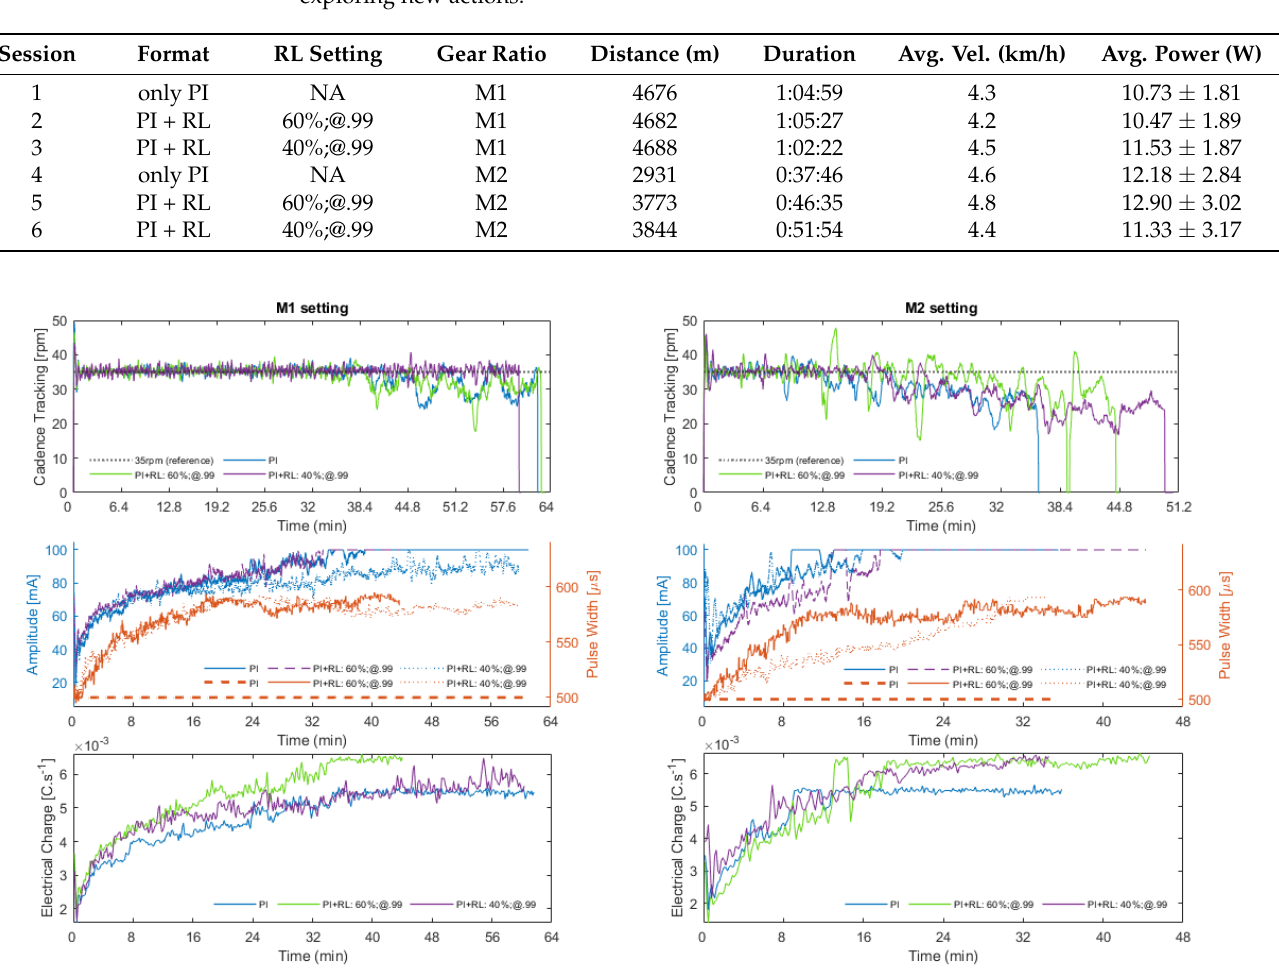
Figure 4. Algorithm performance for M1 (left plots) and M2 (right plots) settings for PI-only, 60% exploration rate and 40% exploration rate configurations. The results presented in subplots are divided into: (1) cadence tracking; (2) modulation of amplitude and pulse width; (3) injected electrical charge. for the six cycling sessions. During the session “M1: P1+RL: 60%;@.99“ the application closed unexpectedly, however, without affecting the interpretation of the data.